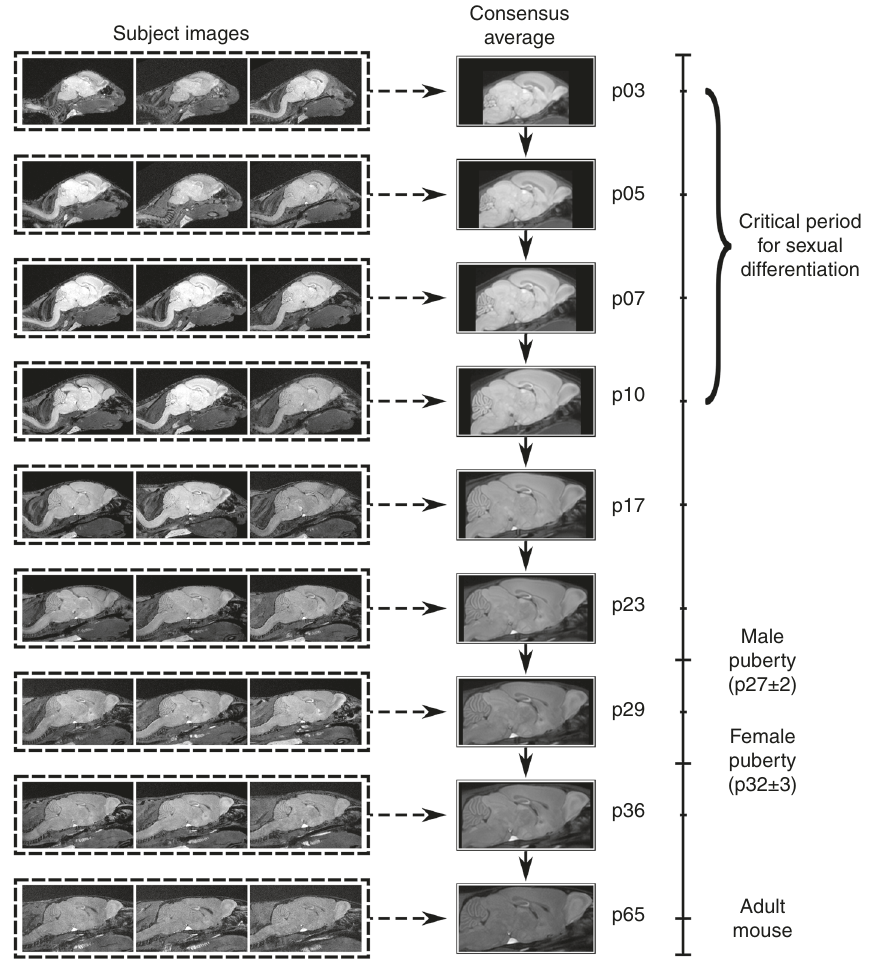
Fig. 2 MR images were registered using a two-level approach. In Level 1 (dashed lines), images from each time point were registered together to create a consensus average for each age. In Level 2 (solid lines), the consensus averages for each age were registered to the following adjacent age. The transformations created from concatenating Level 1 (dashed arrows) and Level 2 (solid arrows) allow us to map points in the p65 consensus average to all